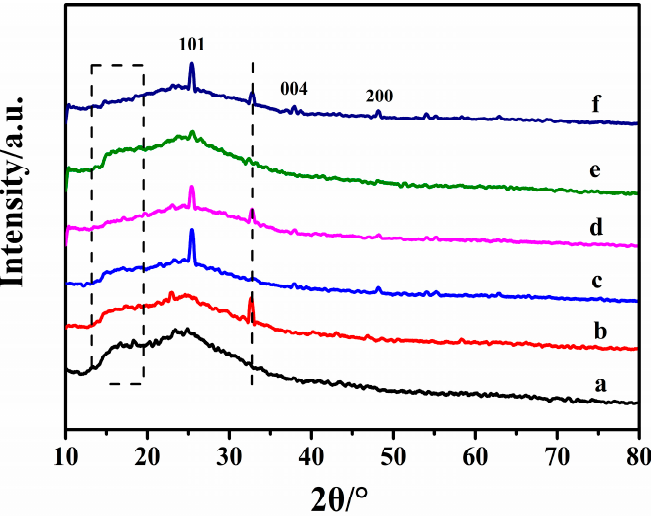
Figure 7. The XRD pattern for films. ( a ) PVC before irradiation ( b ) PVC after irradiation, ( c ) TiO 2 /PVC before irradiation ( d ) TiO 2 /PVC after irradiation, ( e ) La 3+ /TiO 2 /PVC before irra- diation ( f ) La 3+ /TiO 2 /PVC after